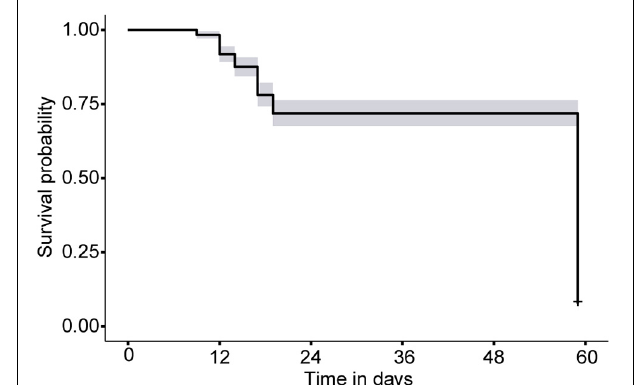
FIGURE 3 | Kaplan-Meier curve depicting survivorship of mapped single polyp recruits on settlement tiles at both sites on St. John United States Virgin Islands. The curve shows survivorship and 95% confidence intervals through 59 days. Time zero corresponds to the point in time when polyps were mapped on the tiles. The large drop in survivorship at 59 days reflects the cumulative loss of individuals between days 20 and